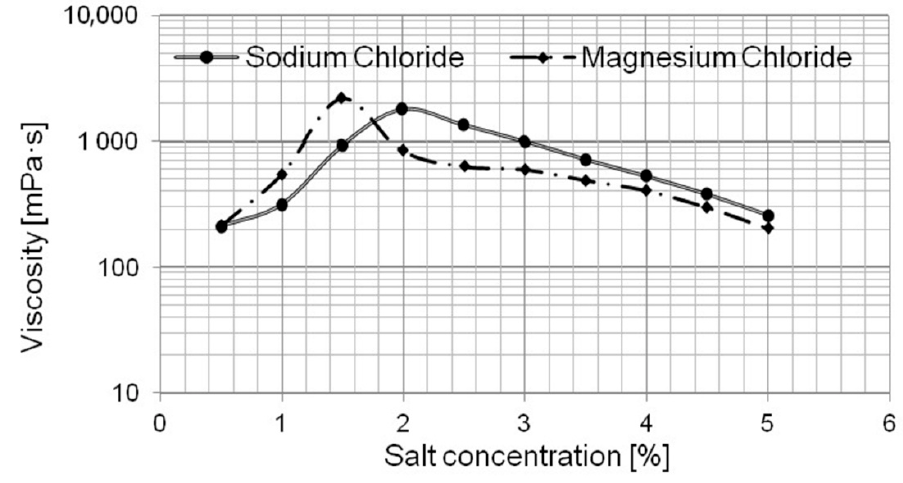
Figure 1. Viscosity of APCs vs. salt concentration for NaCl and MgCl 2 .